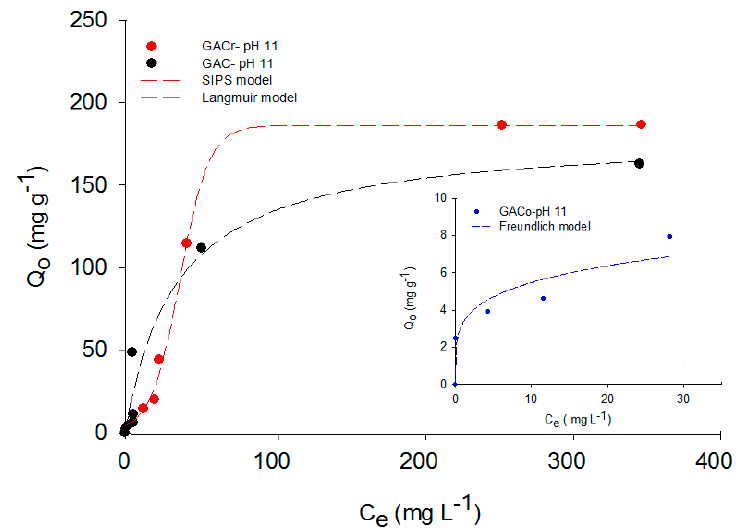
Figure 5. Paracetamol adsorption isotherms on GAC, GACo and GACr at pH 11 and T = 298 K.